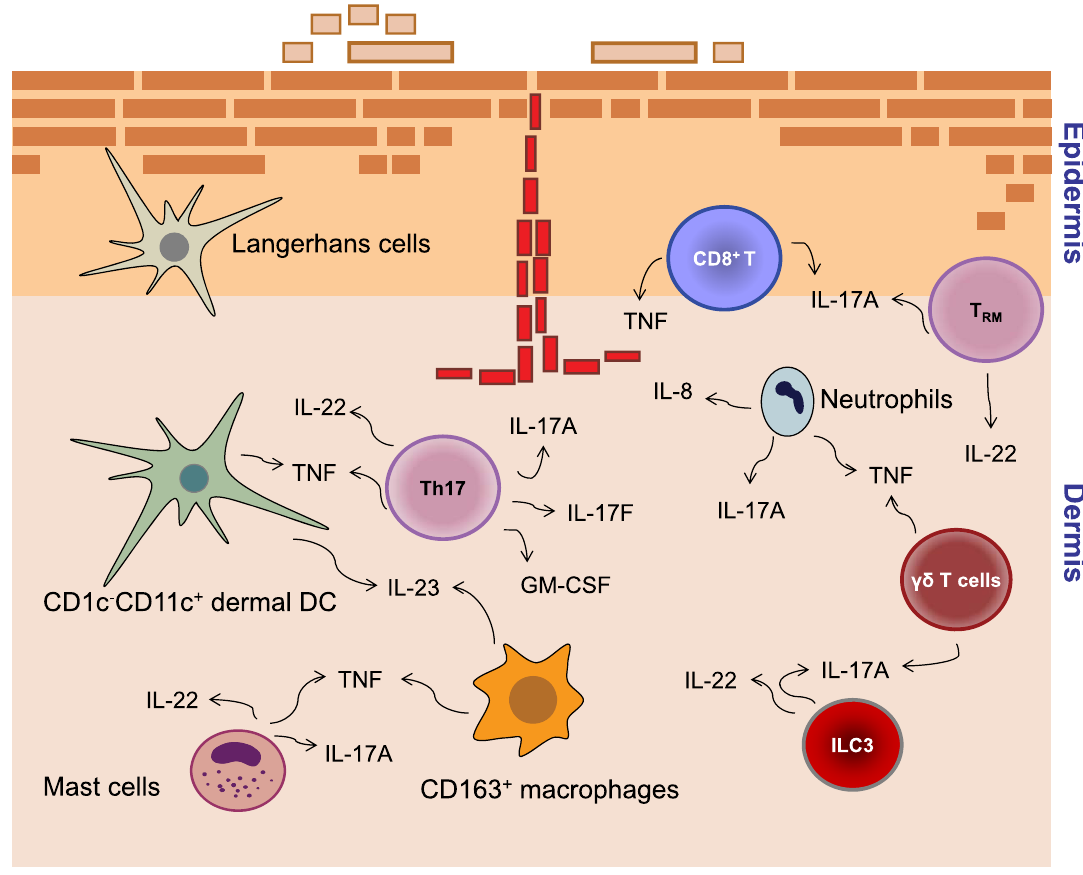
Figure 1. Immune cells and T helper 17 (Th17)-associated cytokines implicated in psoriasis pathogenesis. Characteristic markers and cytokines related to the interleukin (IL)-17/IL-23 immune signature of T cells, dendritic cells (DCs), and associated immune cells in psoriatic skin